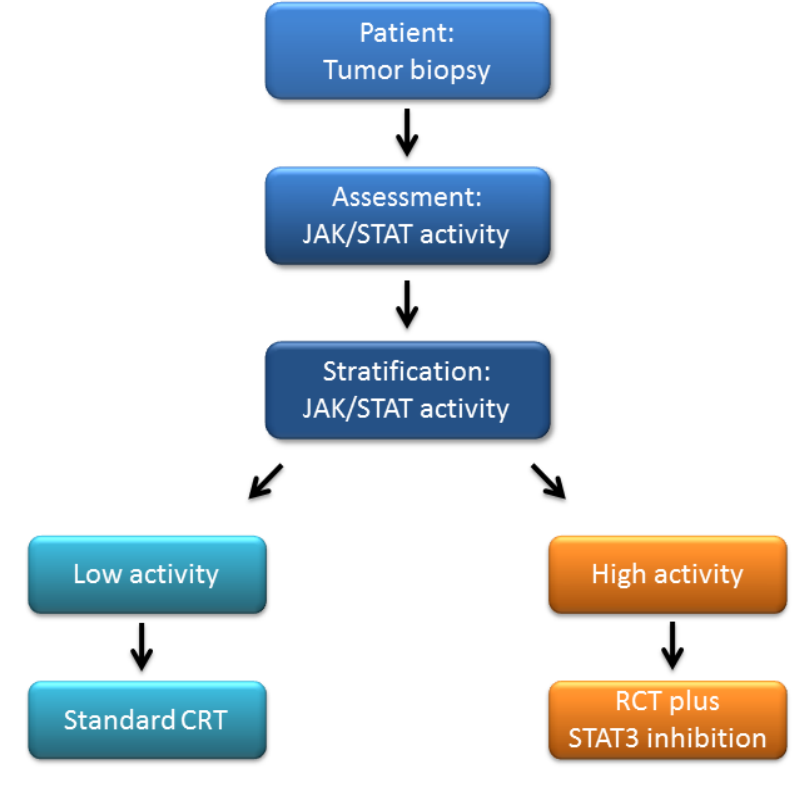
Figure 2. Outlook: JAK/STAT activity-guided patient stratification and